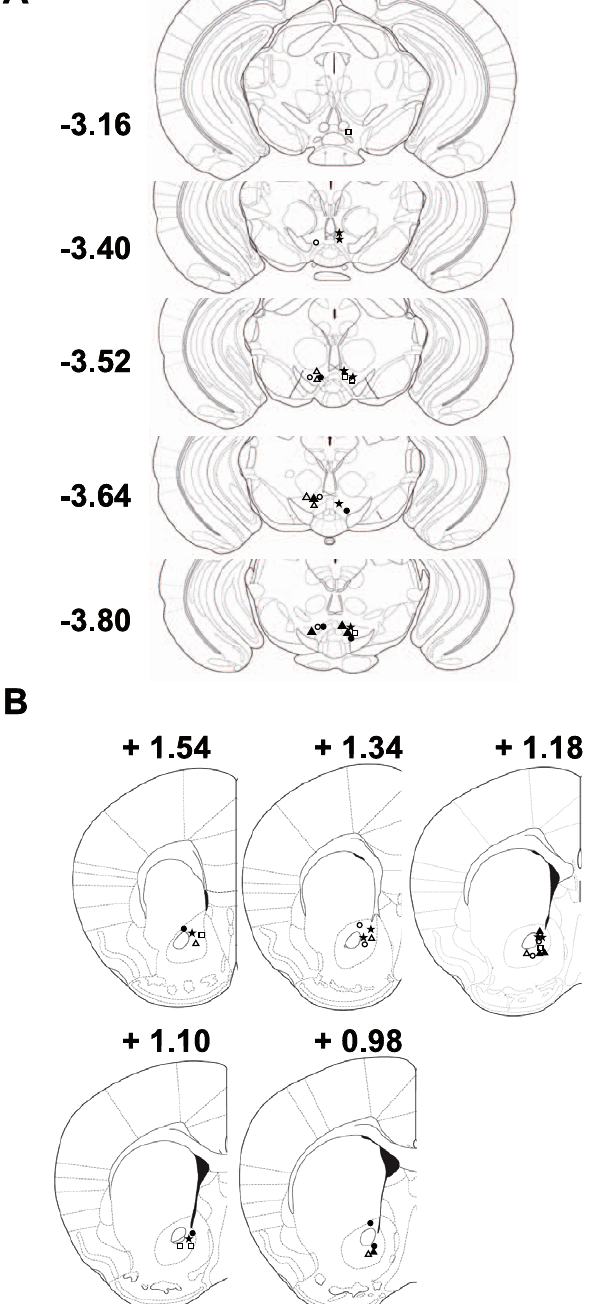
Figure 1. VTA injection sites (A) and nucleus accumbens recording sites (B) used in Experiment 1. In both (A) and (B), open circles show placements from M 5 knockout mice (n=4) treated with 50 ng intra-VTA morphine, closed circles show placements from M 5 knockout mice treated with 0.3 m l intra-VTA saline (n=4), open triangles show placements from wildtype mice (n=4) treated with 50 ng intra-VTA morphine, closed triangles show placements from wildtype mice (n=4) treated with 0.3 m l intra-VTA saline, stars show placements from wildtype mice (n=6) pre-treated with 50 m g intra-VTA scopolamine followed by 50 ng intra-VTA morphine, and open squares show placements from wildtype mice (n=4) pre-treated with 1 mg/kg (i.p.) naltrexone followed by 50 ng intra-VTA morphine. For clarity infusion sites are shown on both left and right side of the brain, but VTA